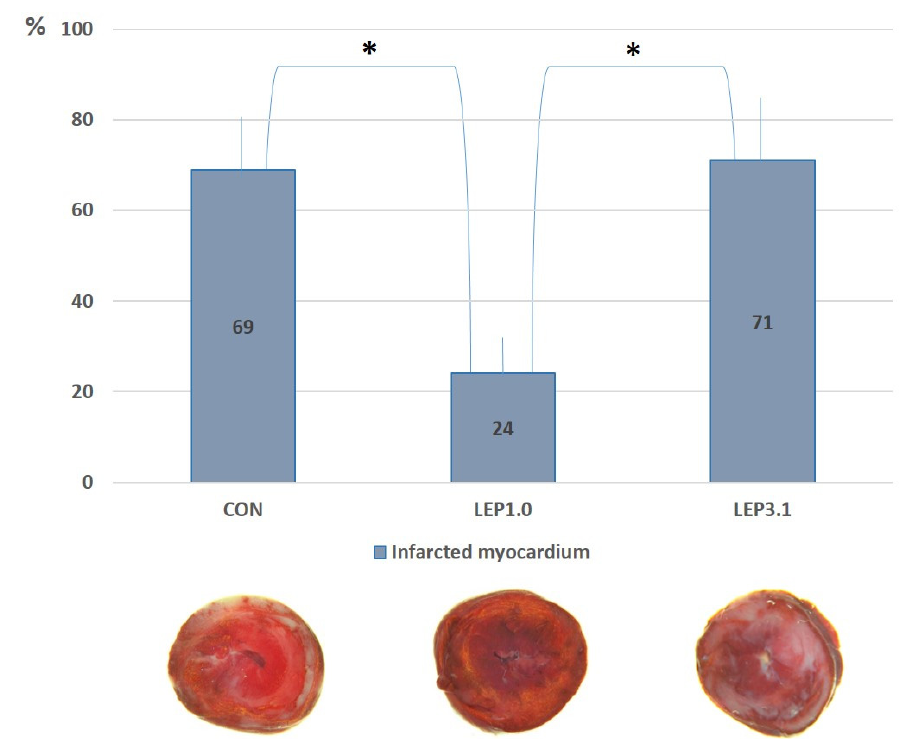
Figure 4. Myocardial infarct size after 120 min reperfusion of the Langendorff-perfused rat hearts subjected to 30 min of global ischemia, sectioned, and stained with 1% 2,3,5-triphenyltetrazolium chloride. CON, control; LEP1.0, leptin 1.0 nM; LEP3.1, leptin 3.1 nM. The data are presented as % of dead tissue ± standard deviation. * p < 0.001. 2.5. Rates of Ventricular Arrhythmia or Asystole during Reperfusion The frequencies of persistent ventricular fibrillation or asystole during reperfusion were 1/10, 0/11, and 1/10 in the CON, LEP1.0, and LEP3.1 groups, respectively. Hearts with persistent ventricular fibrillation or asystole during reperfusion were not included in the analysis of post-ischemic function of the left ventricle; however, they were used for determining infarct